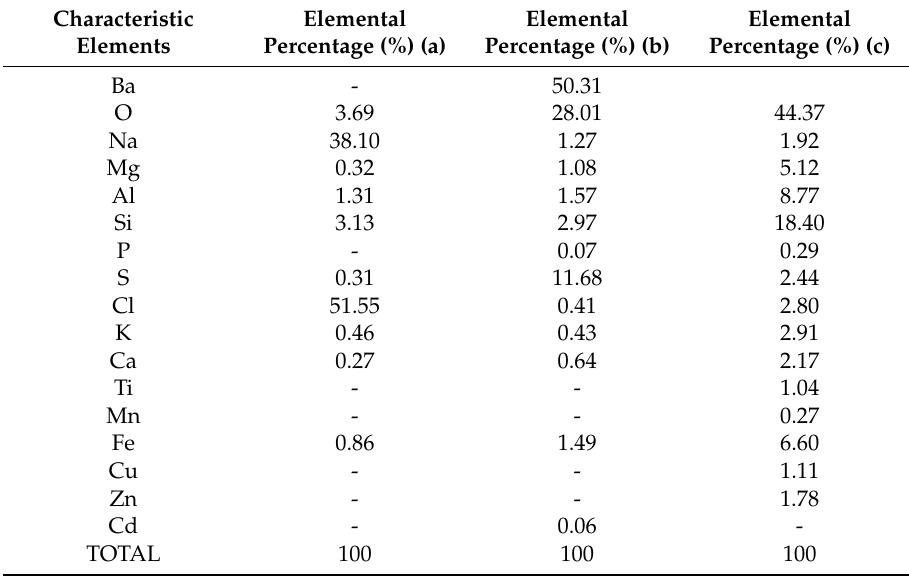
Figure 10. Scanning electron microscopy (SEM) and energy dispersive spectrometer (EDS) analysis for the coatings in the geogrid samples 1 ( a ), 2 ( b ), 3 ( c ). Table 4. Percentage of elements in the coating layer of the geogrids.